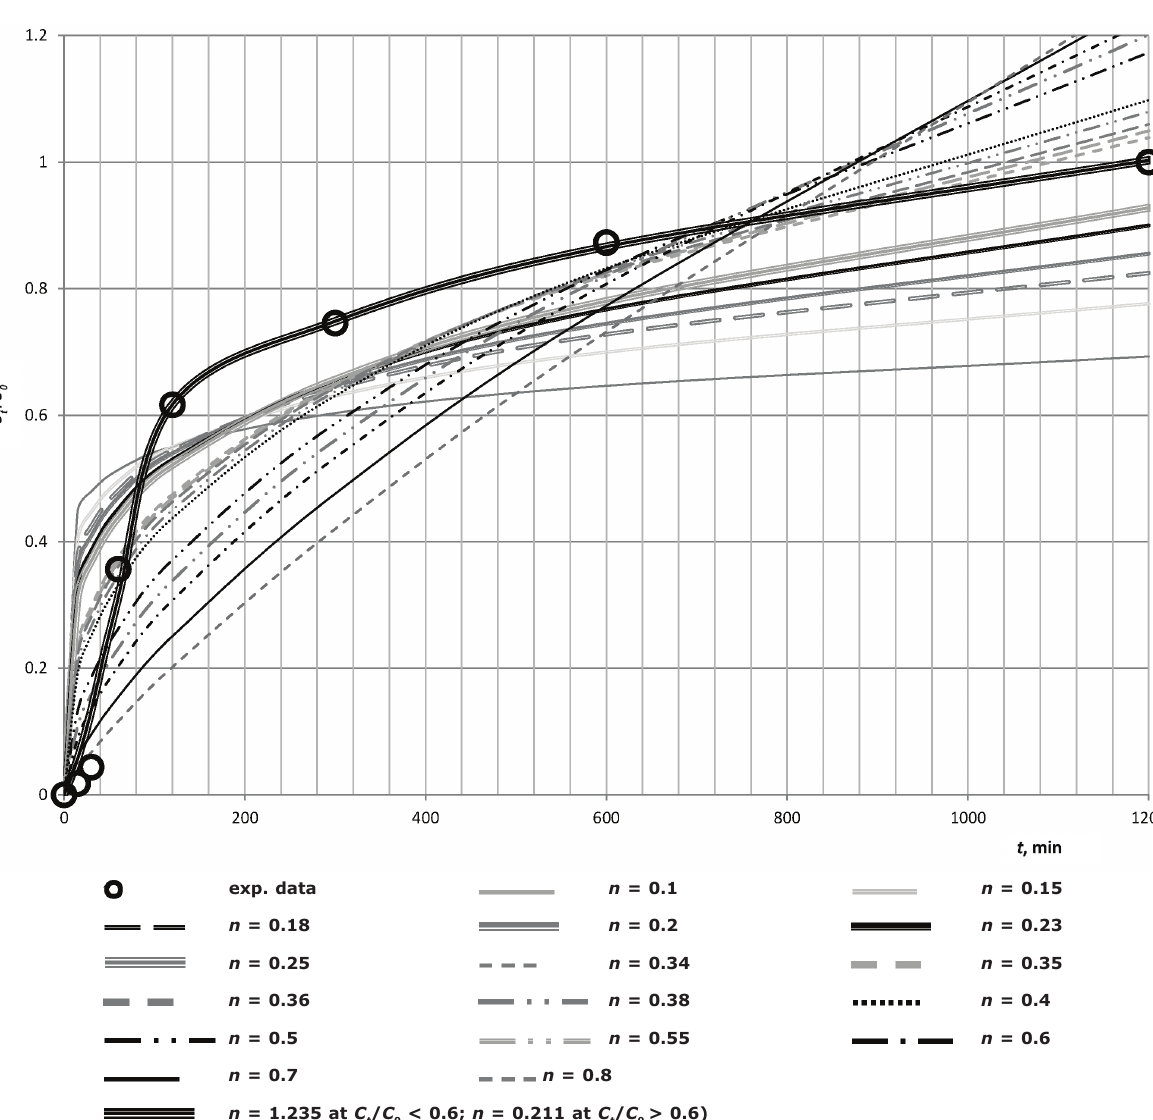
Fig. 8 – Fit of drug dissolution data with: a) Weibull release model, and b) Korsmeyer-Peppas release